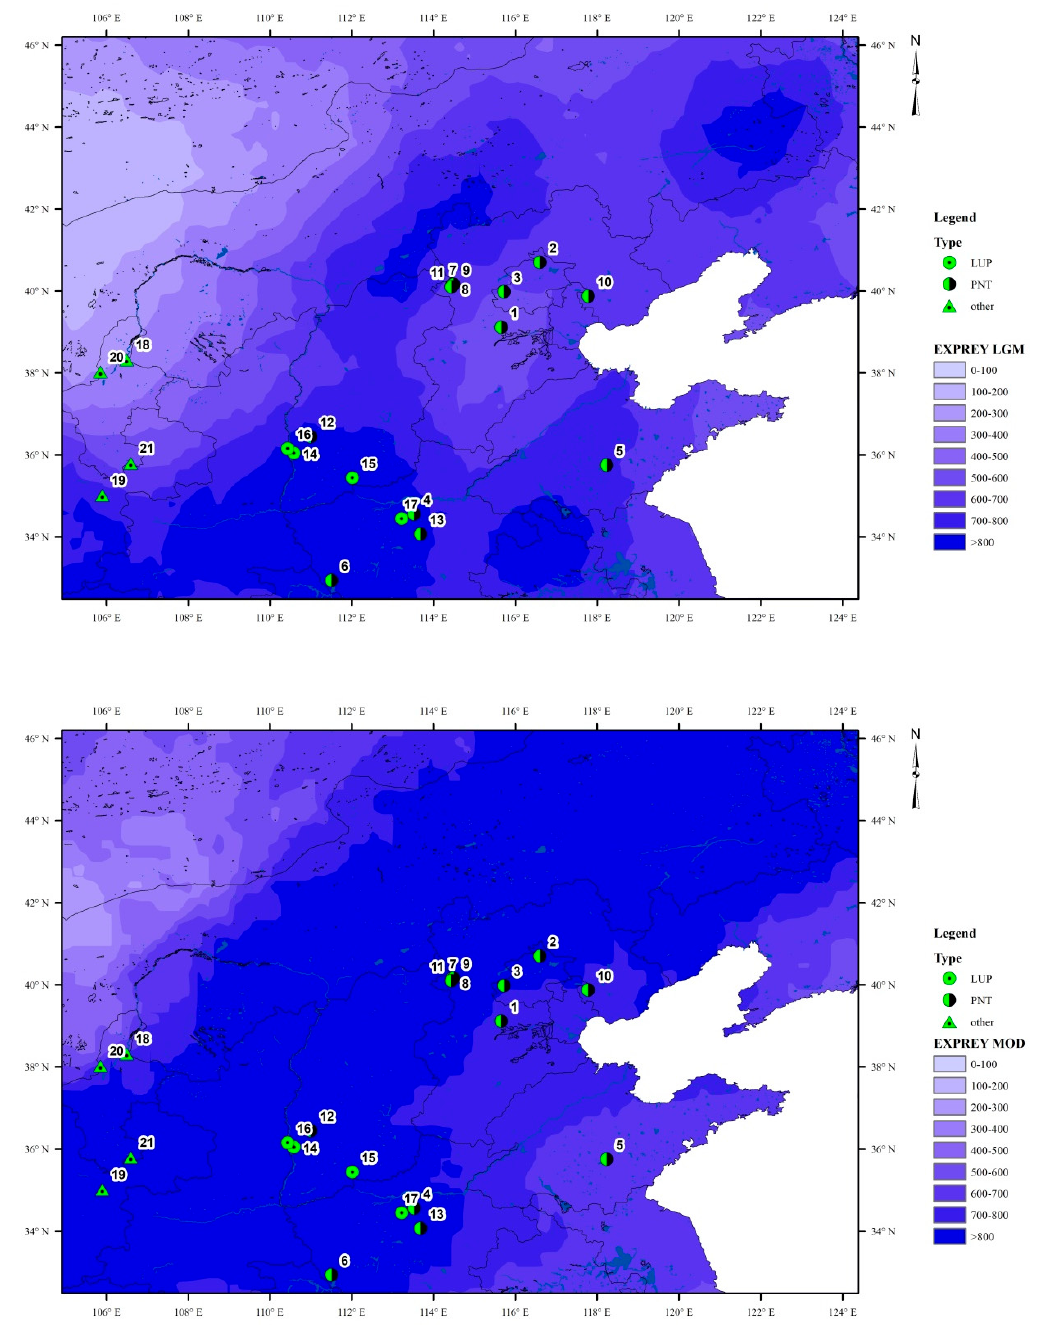
Figure 6. Archaeological sites dated to the Pleistocene to Holocene transition on the maps of secondary biomass (expected moderate body–size ungulate biomass, EXPREY) of northern China under LGM and modern climatic conditions.